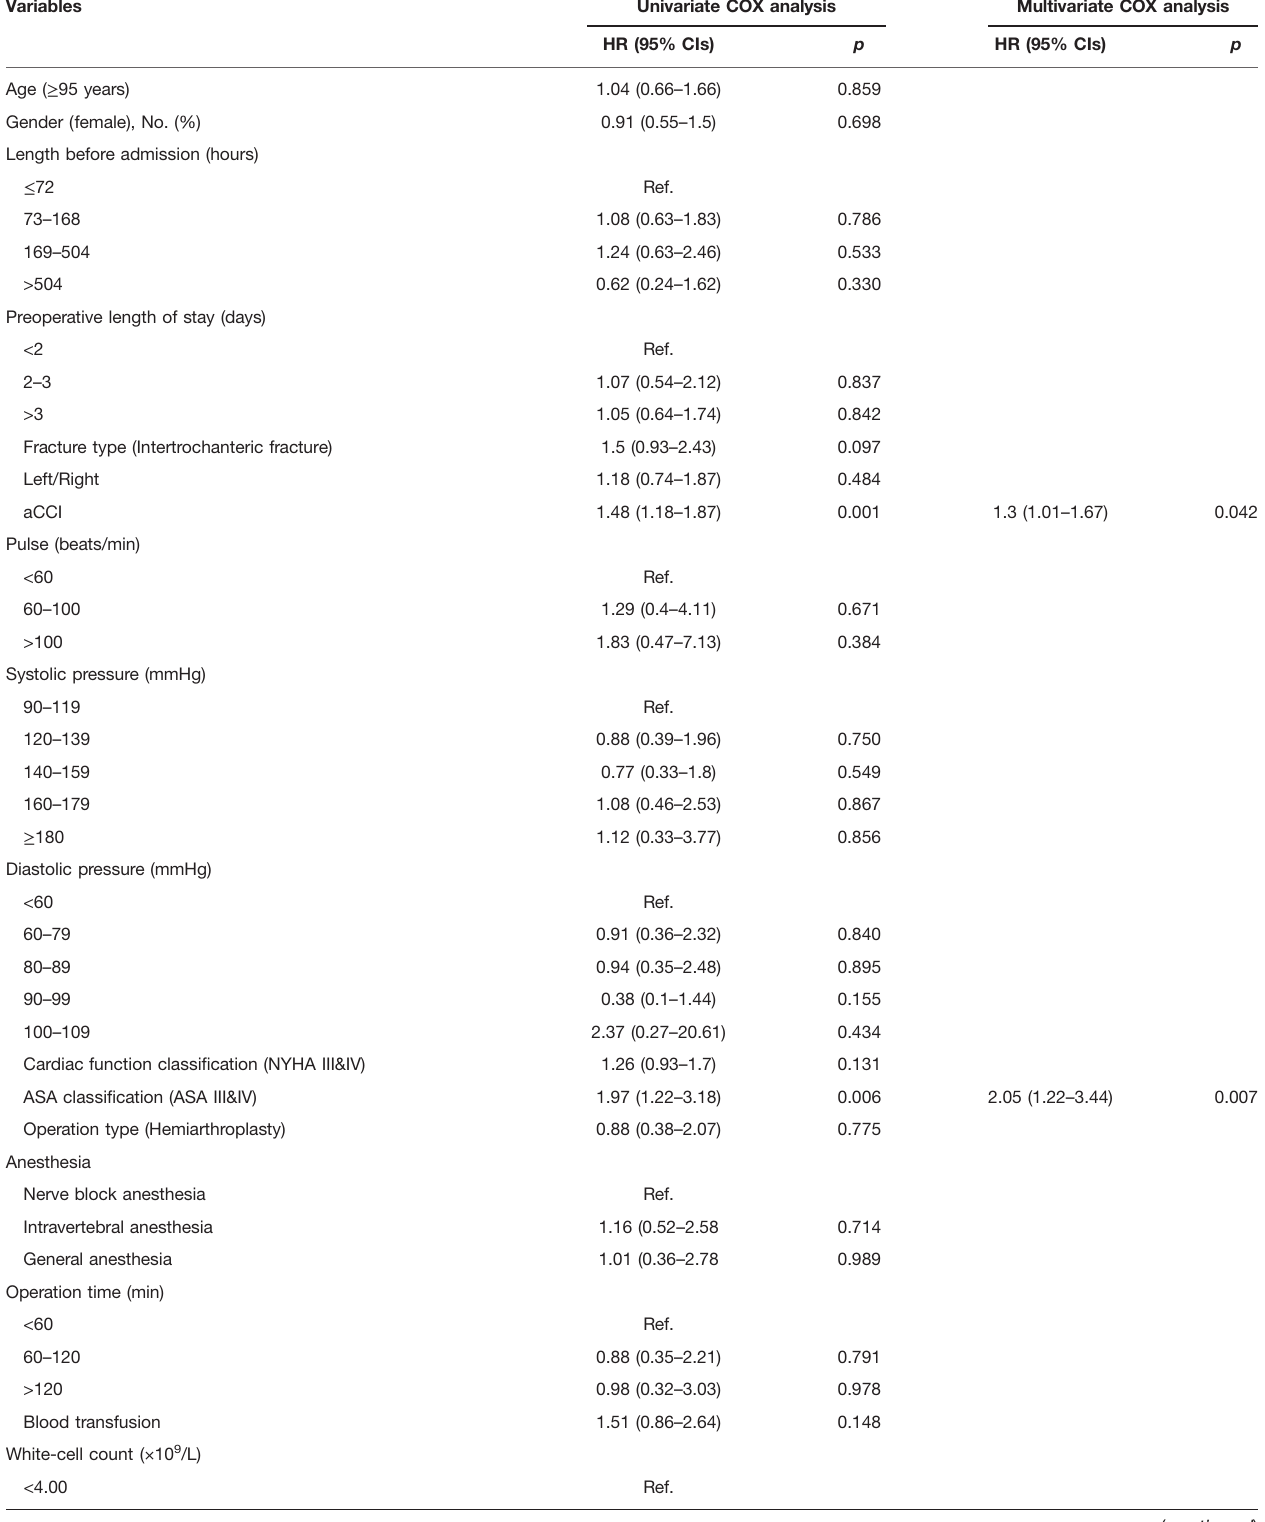
TABLE 3 | Univariate and multivariate COX proportional hazards regression analysis of the fatal outcome of nonagenarians undergoing arthroplasty after hip fracture in the Training